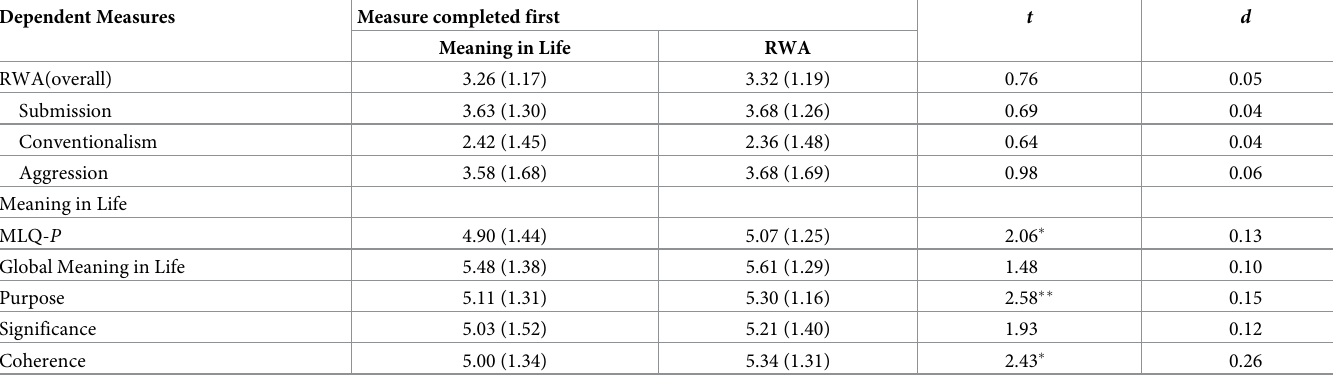
Table 1. Effect of order on meaning in life and right-wing authoritarianism, Study